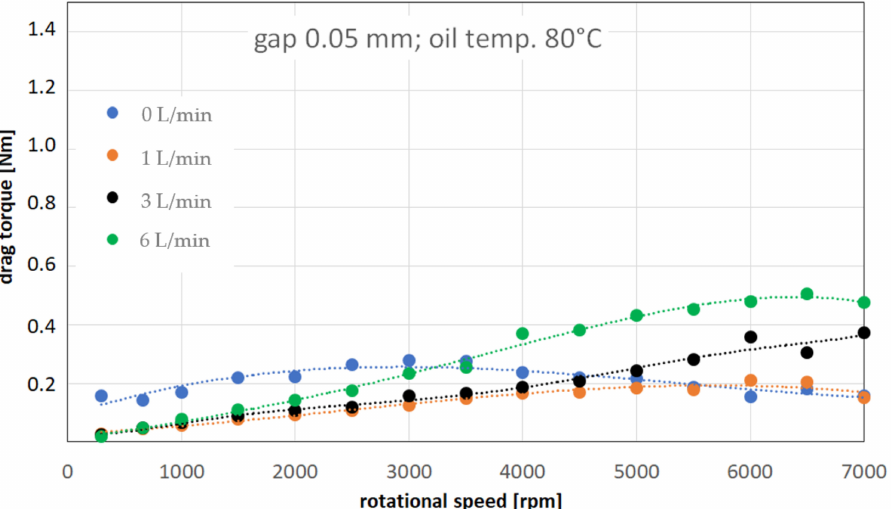
Figure 7. Drag torque characteristics for gap between plates 0.05 mm, oil temperature 80 ◦ C and various values of oil flow